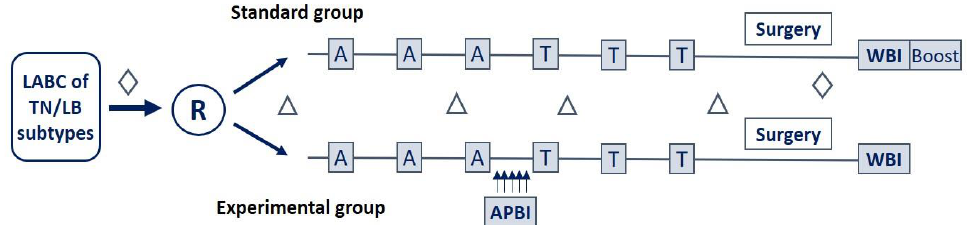
Figure 1. Schematic overview of the study. Patients were randomized to receive either standard treatment consisting of anthracycline/taxane-based NACT or experimental treatment with the same NACT and the addition of a short course tumor-directed APBI between two chemotherapy cycles.